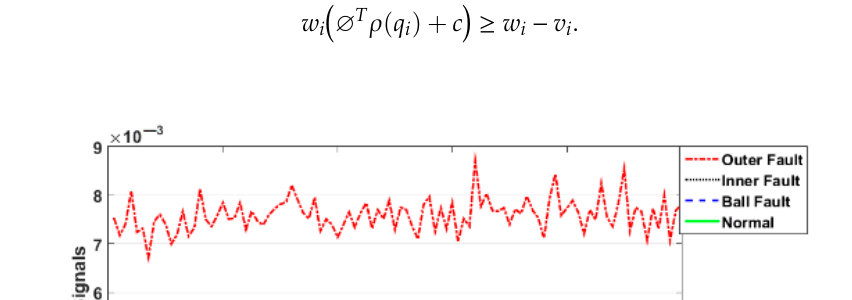
10 of 19 Figure 3. The residual signals for the CWRU dataset using the FOR (fuzzy orthonormal regressive)- adaptive cascade observation procedure. After calculating the residual signals, in the next step, the energy signals are extracted from the residual signals. These signals are used for classification algorithm using SVM. Therefore, the energy signals ((cid:1831)(cid:3364)) extracted from the residual signals is calculated as follows. (cid:1831)(cid:3364) = (cid:3533) (cid:1870) (cid:3007)(cid:3016)(cid:3019)(cid:2879)(cid:3045)(cid:2879)(cid:3002)(cid:3004)(cid:3016)(cid:2879)(cid:3036)(cid:2870)(cid:3012) (cid:3036)(cid:2880)(cid:2869) .